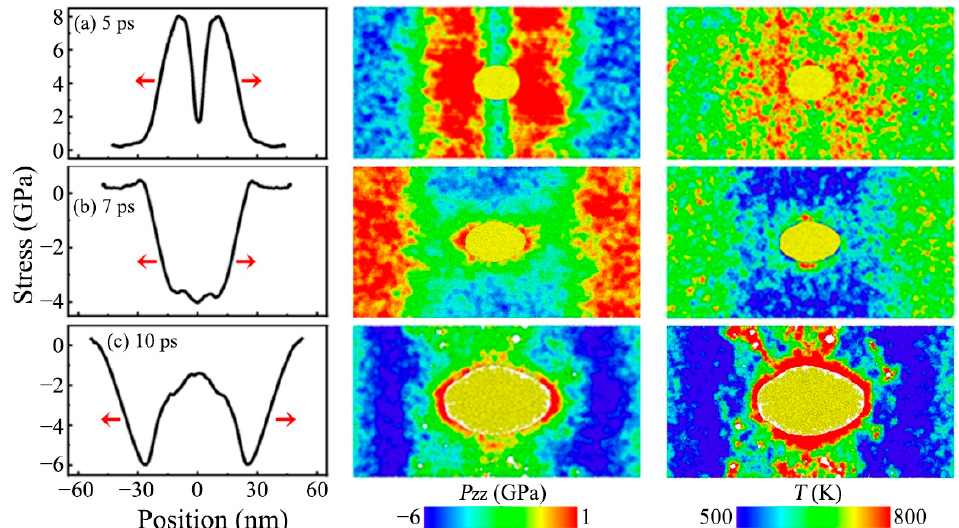
Figure 5. The stress along the release direction and temperature distributions at P H = 11 GPa. ( a – c ) shows the thermodynamic states of the Al-He sample at different moments. The figures are 2D side views of a selected section that is parallel to the release direction and goes through the center of the sample. A slice of 8 Å in y direction is selected.